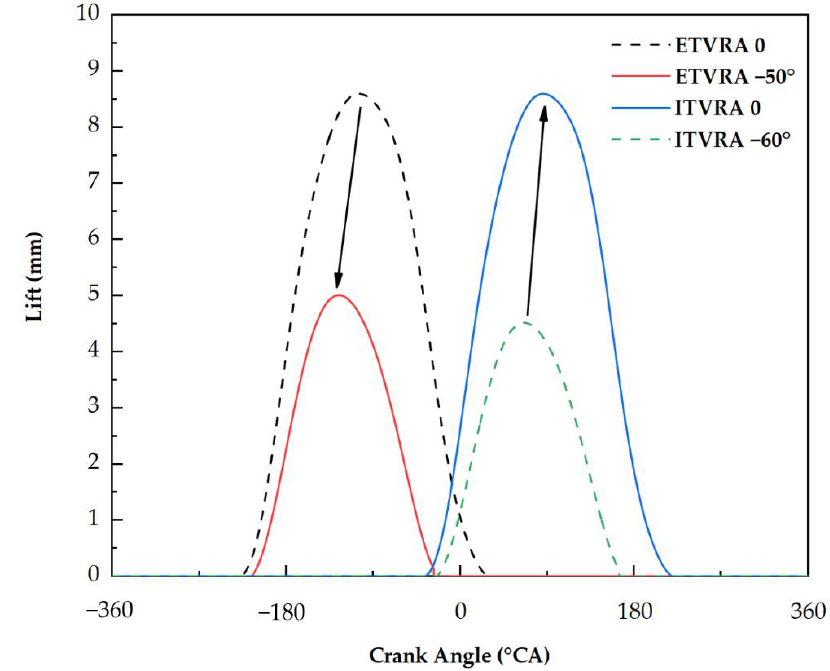
Figure 3. Exhaust and intake valve lift curves of SI and HCCI.